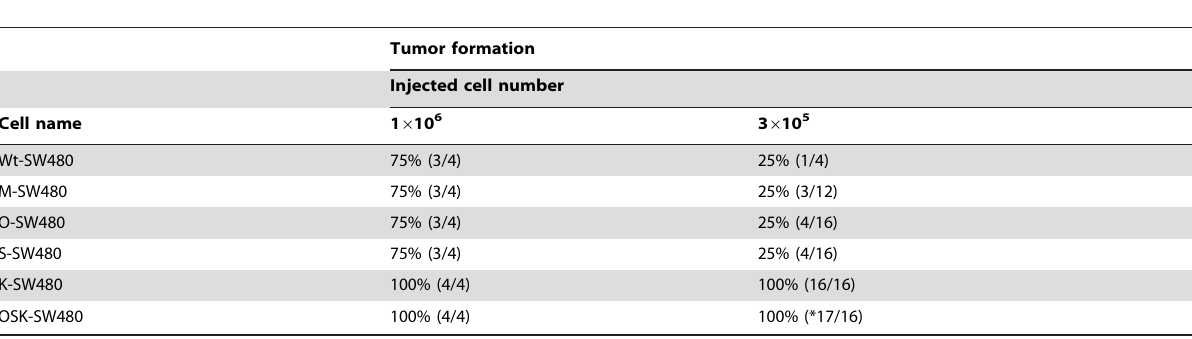
Table 1. Summary of tumor formation derived from transduced SW480